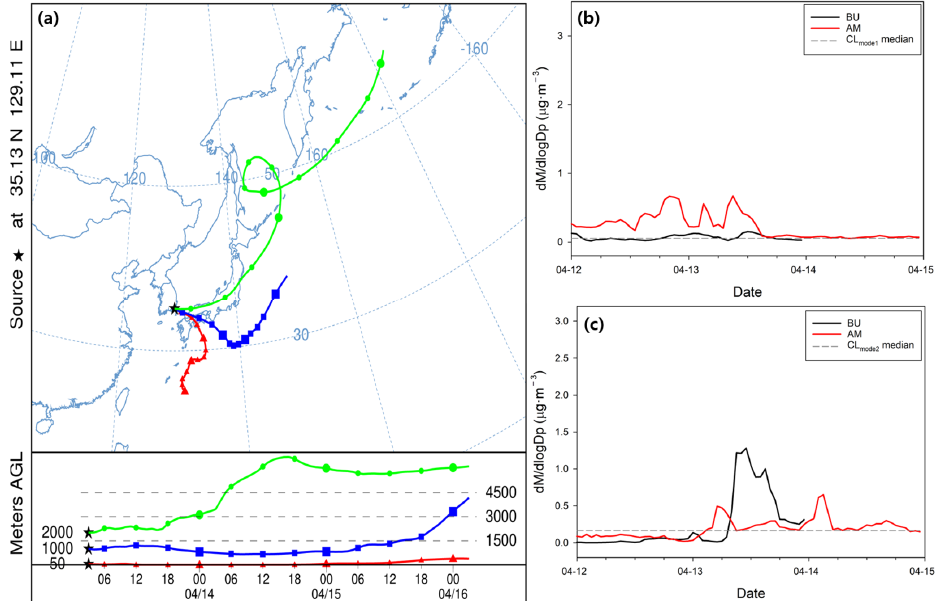
Figure 11. ( a ) Backward trajectory of air masses at 0300 UTC 13 April 2010 in Busan. Time series of aerosol mass concentrations in ( b ) Mode 1 and ( c ) Mode 2 at Busan (black line) are presented with those of Anmyeondo (red line) for 9–12 January 2009. The dashed lines are the median aerosol mass concentrations for the CD cases in Modes 1 and 2, respectively.